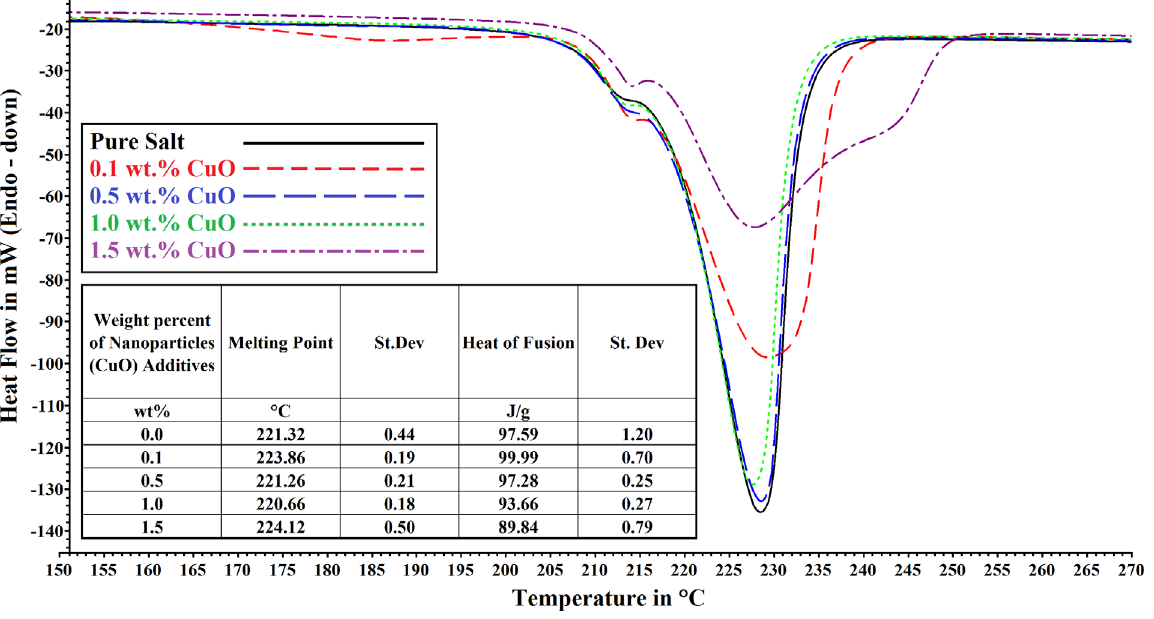
Figure 2. Differential scanning calorimetry (DSC) curves of NaNO 3 and KNO 3 eutectic mixture (60/40) with and without CuO nanoparticles. Table inserted in the graph shows the average melting point and heat of fusion values.